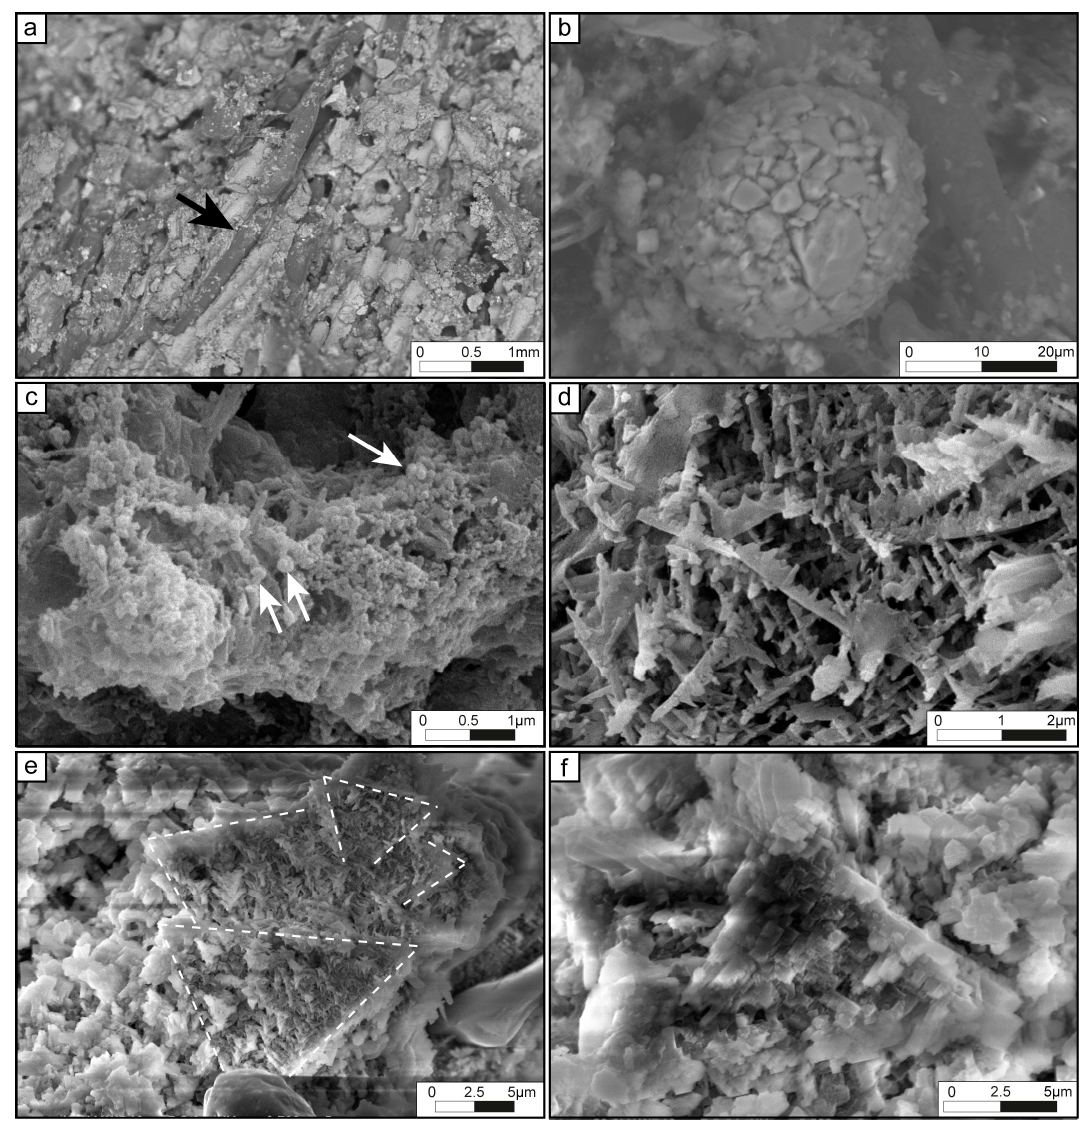
Figure 5. Microstructures of tufa microbialite in SEM view. ( a ) Remnants of sheaths of filamentous cyanobacteria ( Phormidium sp.; black arrow) embedded in carbonate matrix; ( b ) micro-peloids composed of carbonate grains; ( c ) aggregates of nanospheres (white arrows); ( d ) dendrites formed by long acicular crystals; ( e ) trigonal polyhedra and ( f ) rhombohedra forming triangular masses.